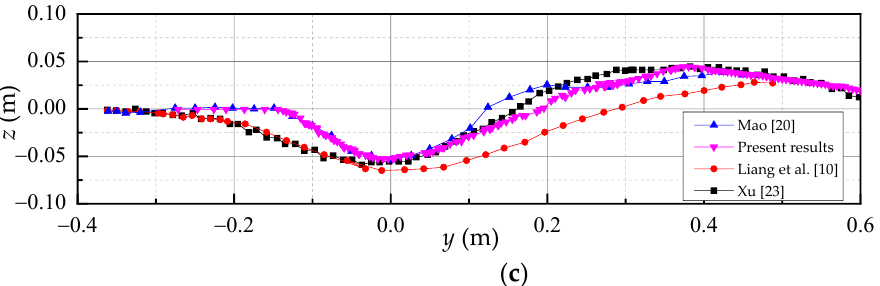
Figure 3. Comparison of scour hole profiles below the pipeline: ( a ) t = 10 min; ( b ) t = 30 min; ( c ) t = 200 min.